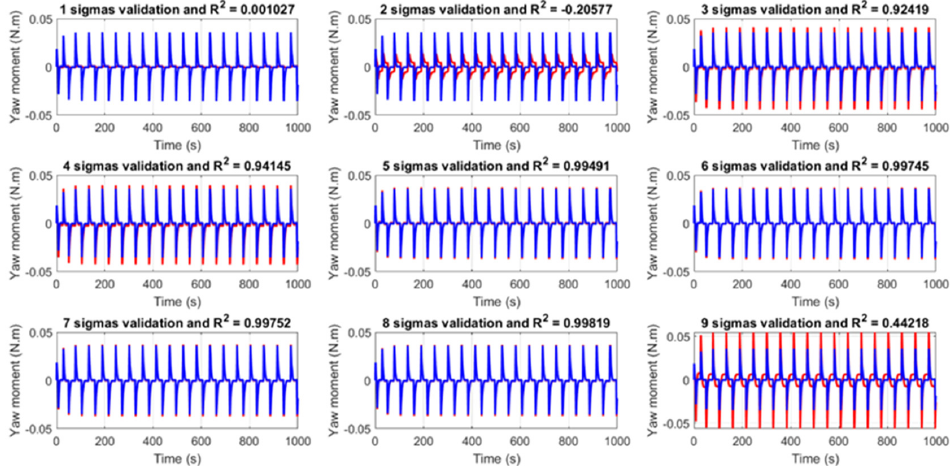
Figure 8. Results from the validation for yaw motion with a 20°–20° zigzag manoeuvre.